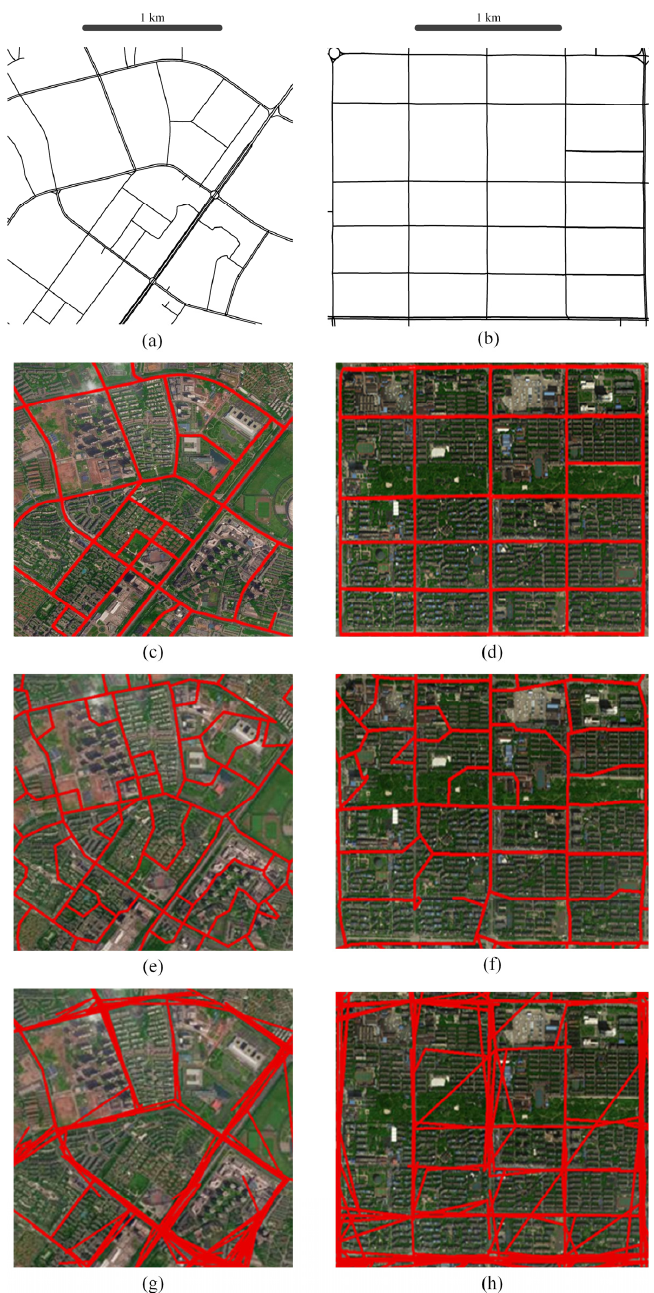
Figure 5. Comparison of road map construction results with benchmark and orthoimage.